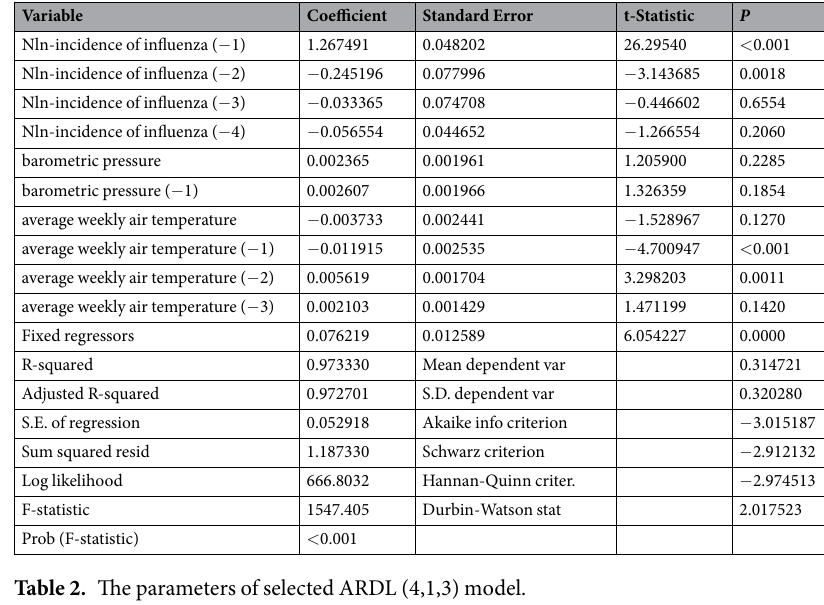
Table 2. The parameters of selected ARDL (4,1,3) model.